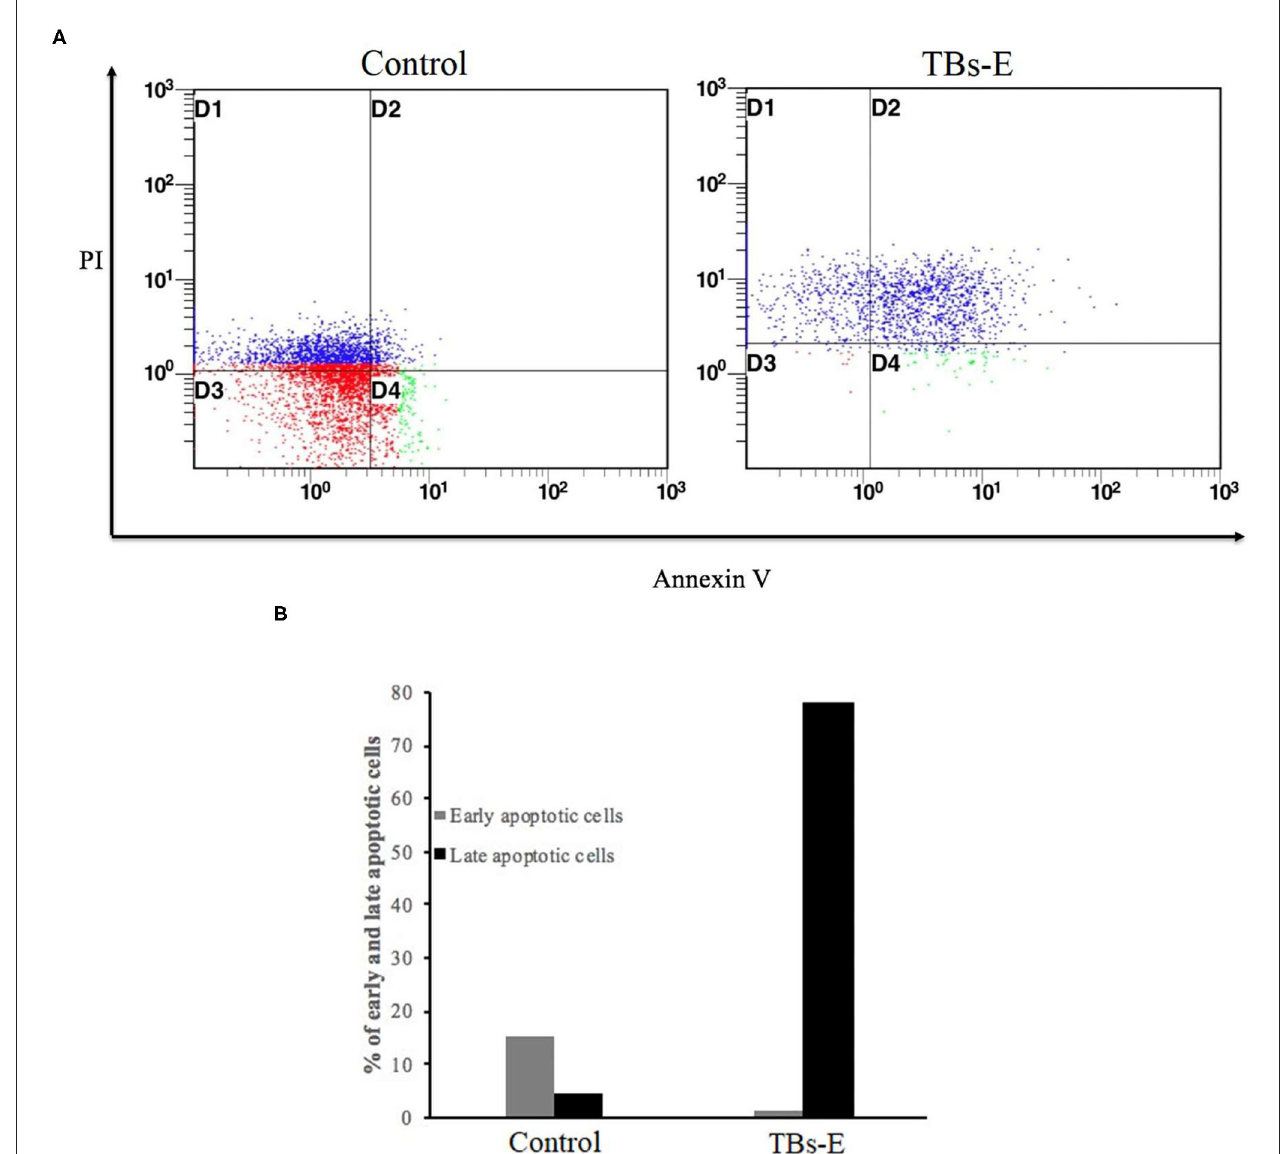
FIGURE 9 | Determination of the apoptotic rate by flow cytometry; (A) PI-annexin V flow cytometry to detect cell apoptosis and (B) statistical analysis of cell apoptosis.